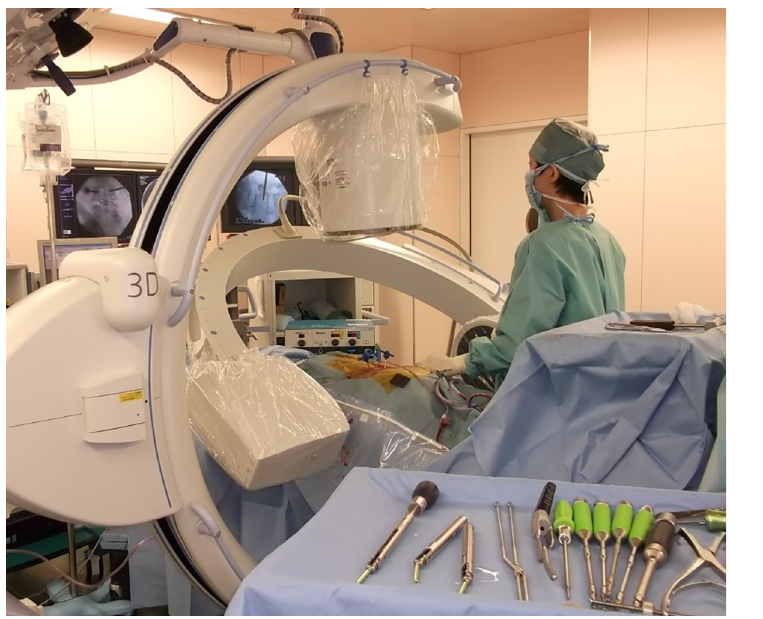
Fig 1. Percutaneous pedicle screw insertion in a two-way C-arm